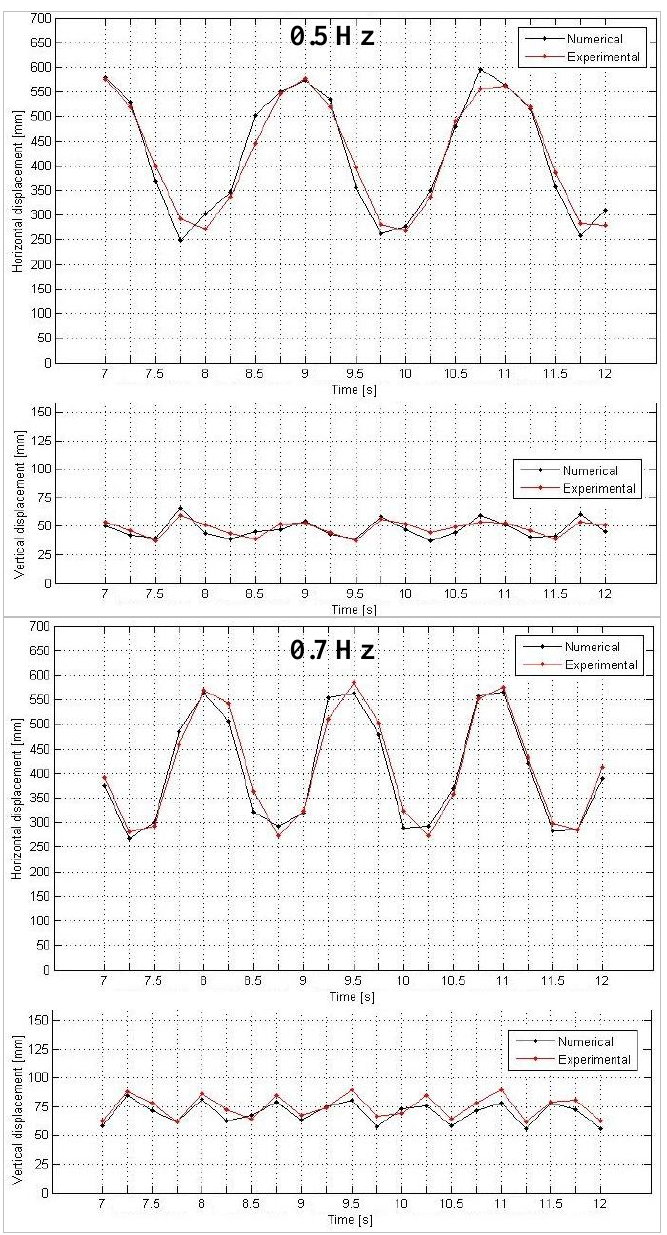
Figure 11. Comparison between numerical and experimental data in the time interval [7 ÷ 12] s: horizontal displacements and vertical displacements.